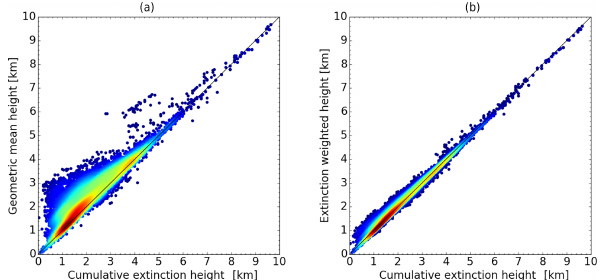
Figure 1. (a) The CALIOP cumulative extinction height versus the CALIOP geometric mean height. Linear regression ( y = ax + b ) gives a = 0 . 882, b = 0 . 6813, R 2 = 0 . 941 and RMSE = 0.652km. (b) The CALIOP cumulative extinction height versus the CALIOP extinction weighted height. Linear regression analysis gives a = 0 . 9619, b = 0 . 1597, R 2 = 0 . 9942 and RMSE =